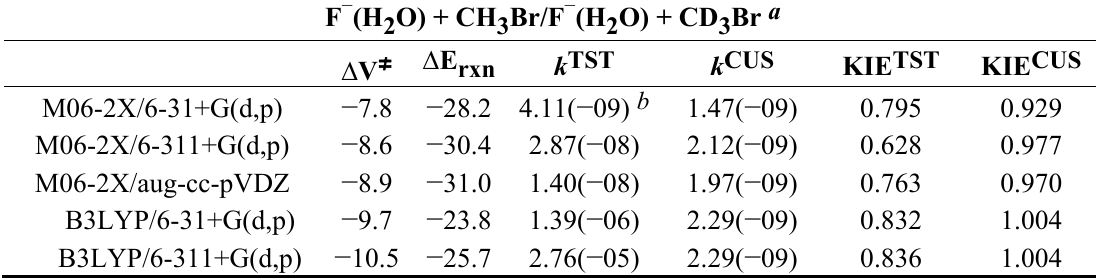
O) + CH Br reaction at 302 K in 2 3